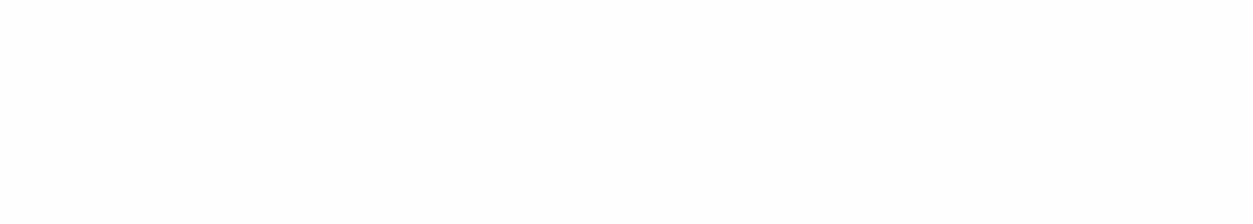
FIGURE 10 The non-smoothed curve of scaling behavior of Grand Charmont near Montb61iard for three periods. In course of urbanization the fluctuations are attenuated and a clear mean behavior